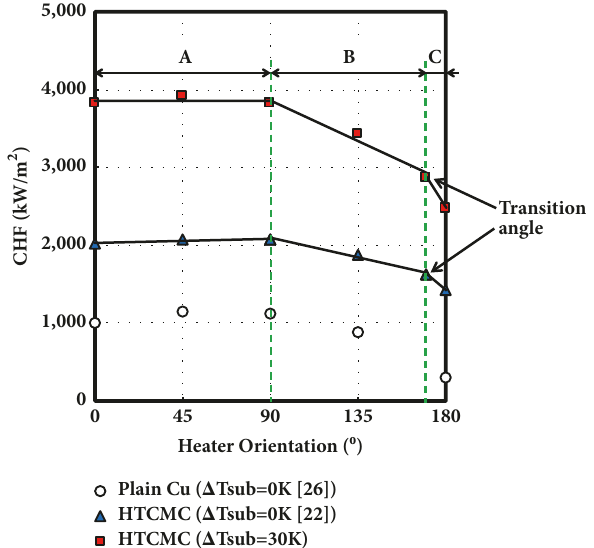
Figure 11: CHF comparison of HTCMC with orientation between saturation and 30K subcooling; A: upward to vertical (0–90 ∘ ), and B: vertical to downward facing (90–170 ∘ ), and C: downward facing to complete downward (170–180 ∘